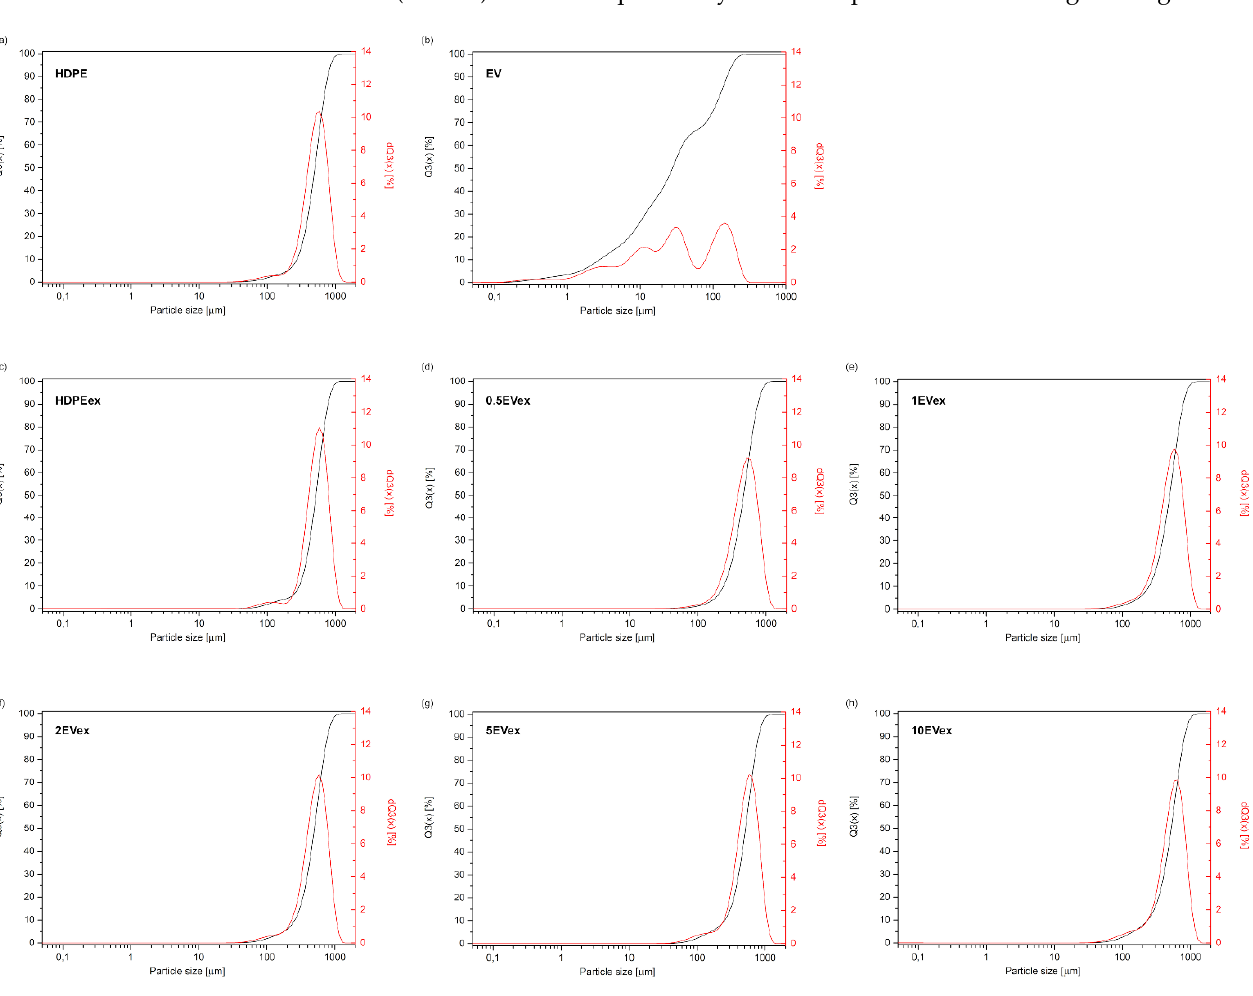
Figure 3. Particle size distribution of polymer powders and expanded vermiculite (EV). ( a ) HDPE, ( b ) EV (expanded vermiculite), ( c ) HDPEex, ( d ) 0.5EVex, ( e ) 1EVex, ( f ) 2EVex, ( g ) 5EVex, ( h )